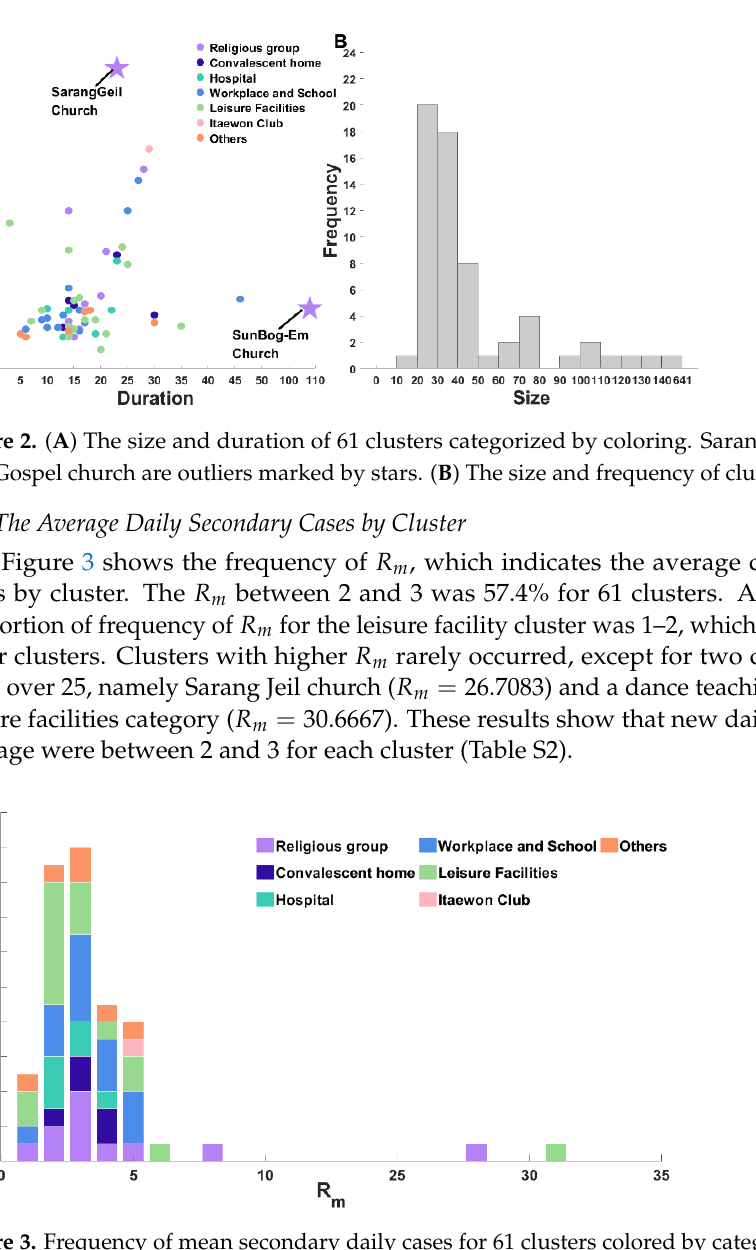
Figure 3. Frequency of mean secondary daily cases for 61 clusters colored by category.